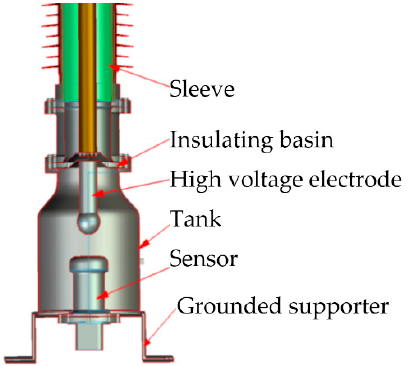
Figure 1. The principle of OVT.